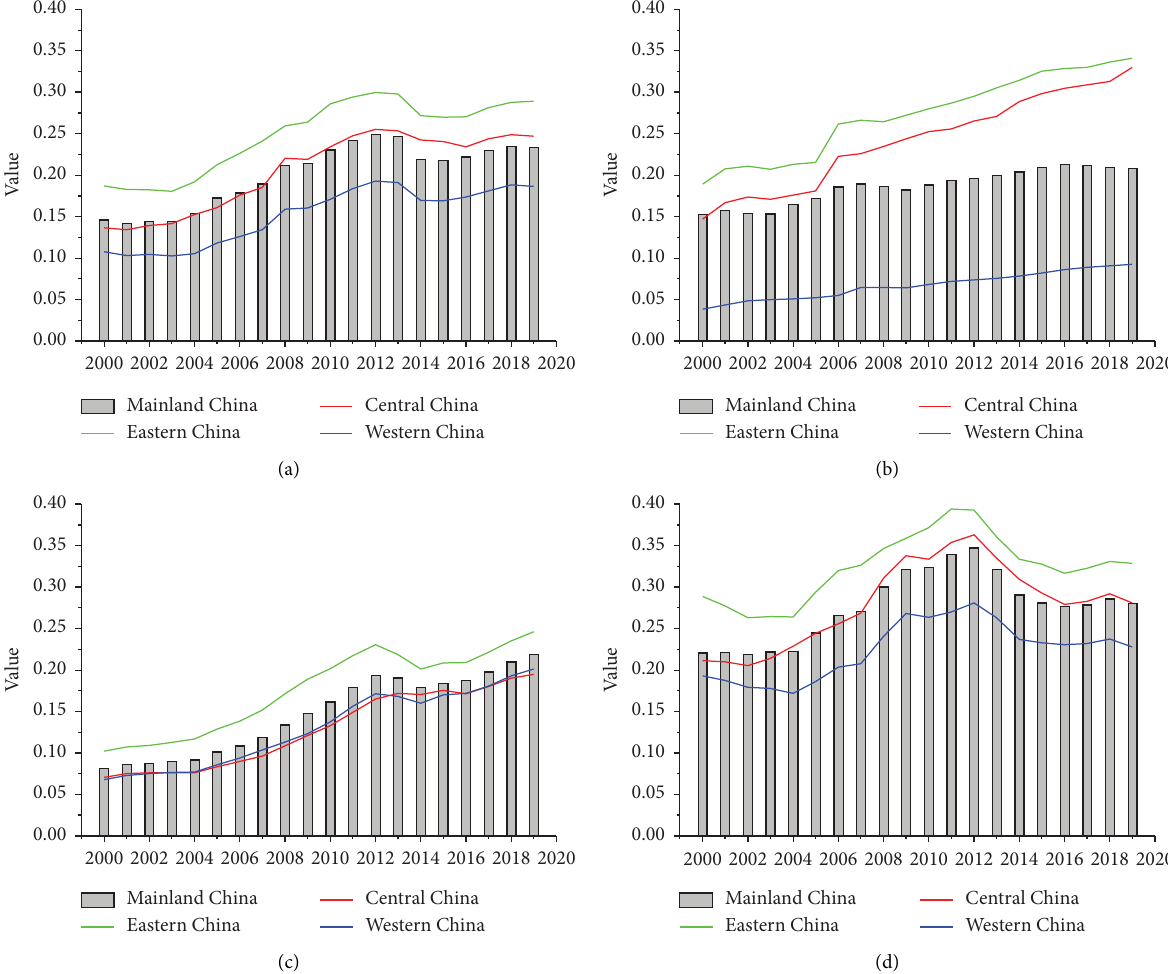
Figure 2: Changes in the comprehensive evaluation value of the three dimensions for the whole country and the eastern, central, and western regions. (a) A comprehensive transportation index. (b) Transportation infrastructure. (c) Scale of transportation. (d) Transportation